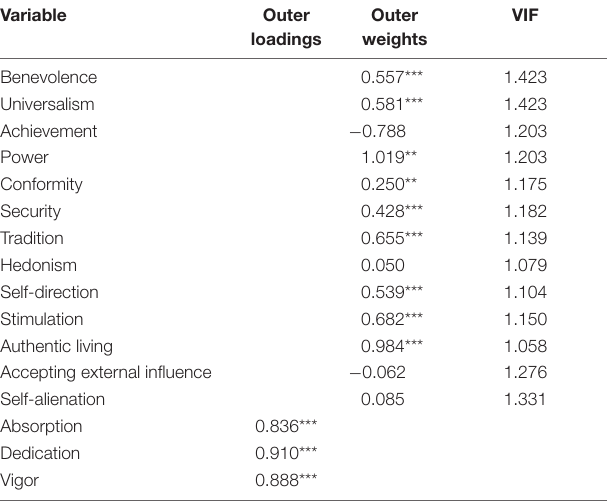
TABLE 4 | Measurement model 2 and reliability and validity.